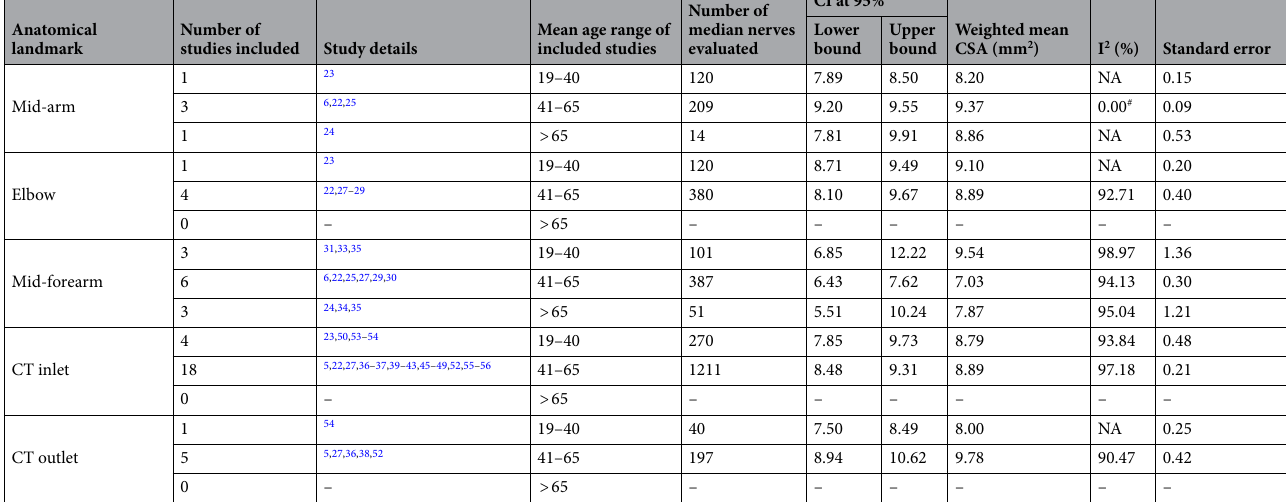
Table 2. Summary of pooled weighted mean of median CSA (n = 34 studies) based on mean age groups at various anatomical landmarks of the upper limb. CSA = cross sectional area. NA indicates the inclusion of only one study for the analysis, hence heterogenicity (I 2 ) cannot be calculated. # Indicates inclusion of study from same authors/research